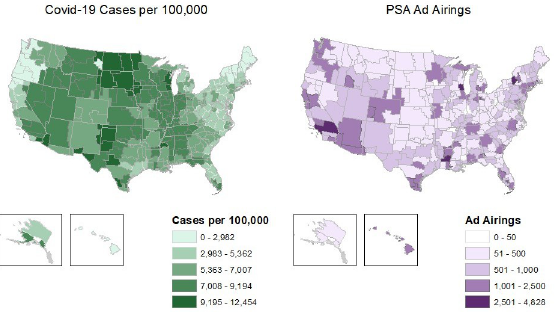
Fig 2. Maps of COVID-19 cases and PSA Ad airings, by media market in the U.S., March-December 2020. Authors’ analysis of data of PSA airings from Kantar/CMAG and data on COVID-19 incidence from the New York